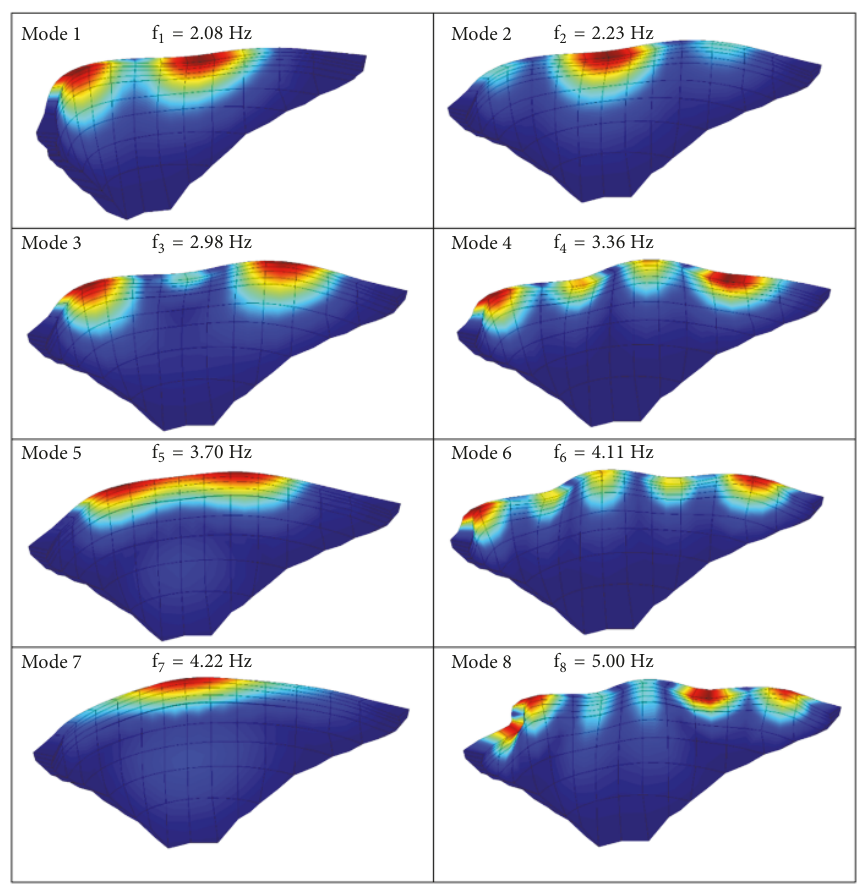
Figure 2: Main natural frequencies and mode shapes, computed for full reservoir.